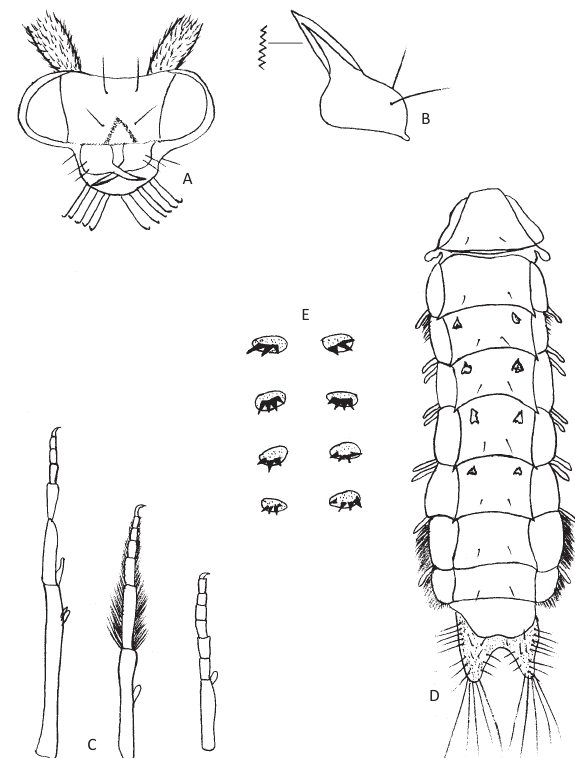
Figure 3. Pupa of Lepidostoma nuburagangai sp. nov. A - Head of female, frontal; B - right mandible, dorsal; C - from right to left, left protarsus, left mesotarsus and left metatarsus, posterior; d - abdominal segments, dorsal. E - anterior hook plates of abdominal segments